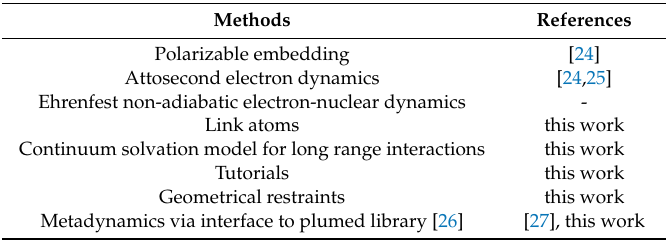
Table 1. New features of deMon2k for quantum mechanical / molecular mechanical (QM / MM) simulations with respect to 2015 review paper